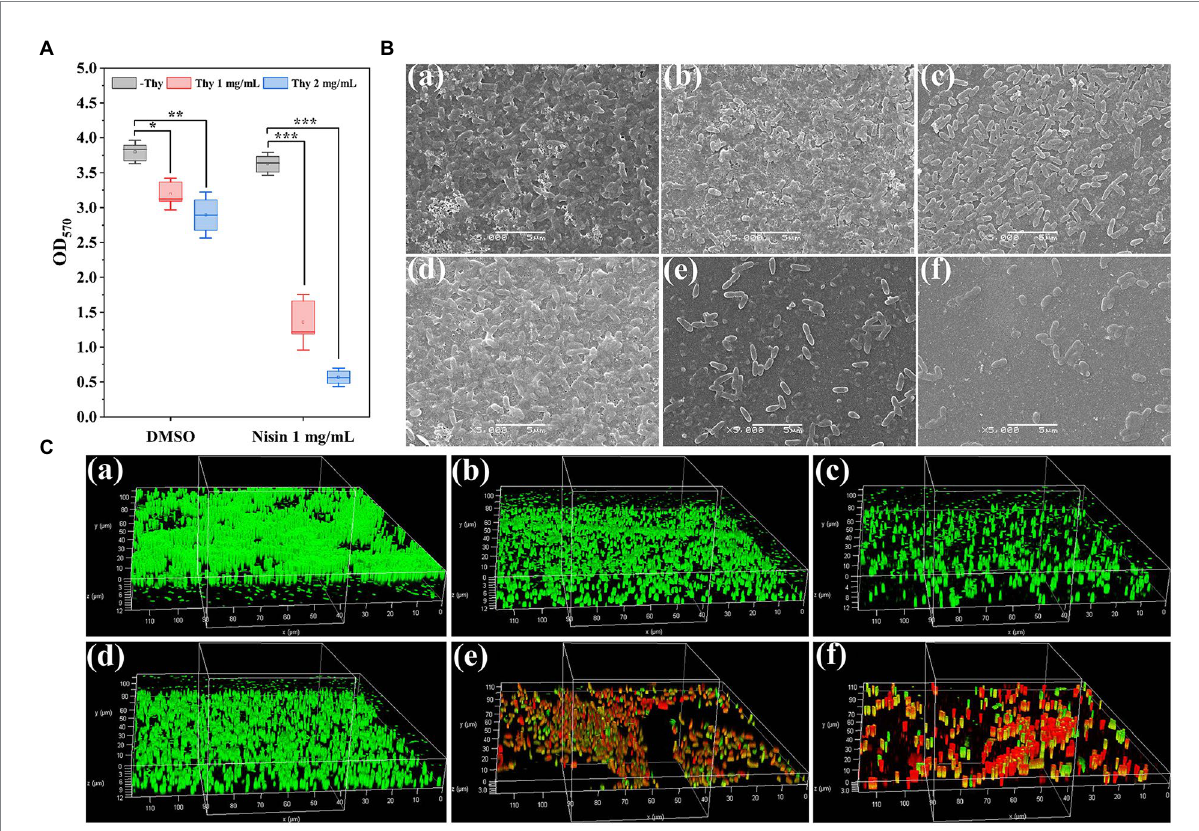
FIGURE 4 Inhibitory effect of thymoquinone and nisin on biofilm formation of P. aeruginosa PAO1 on microplates. (A) Quantification of biofilms using crystal violet staining method. (B,C) represented the SEM and CLSM images of biofilms, respectively, treated with (a) DMSO, (b) 1 mg/ml of thymoquinone, (c) 2 mg/ml of thymoquinone, (d) 1 mg/ml of nisin, (e) 1 mg/ml of nisin +1 mg/ml of thymoquinone, (f) 1 mg/ml of nisin +2 mg/ml of thymoquinone, respectively. Statistical differences were determined by ANOVA followed by the Tukey–Kramer test. ( ∗∗∗ ) p < 0.001 versus the DMSO